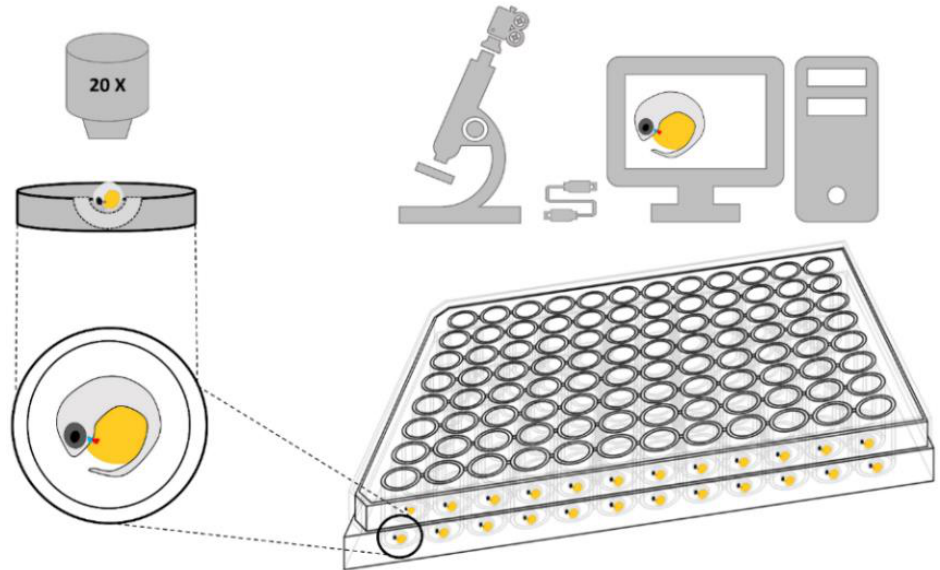
Figure 1. Illustration of embryos in 96-well microplate for stereomicroscope imaging and video recording. Embryos were allocated individually into each well and immobilised in pre-prepared ‘U’ shaped depression in agarose block with the heart facing towards the eyepiece.